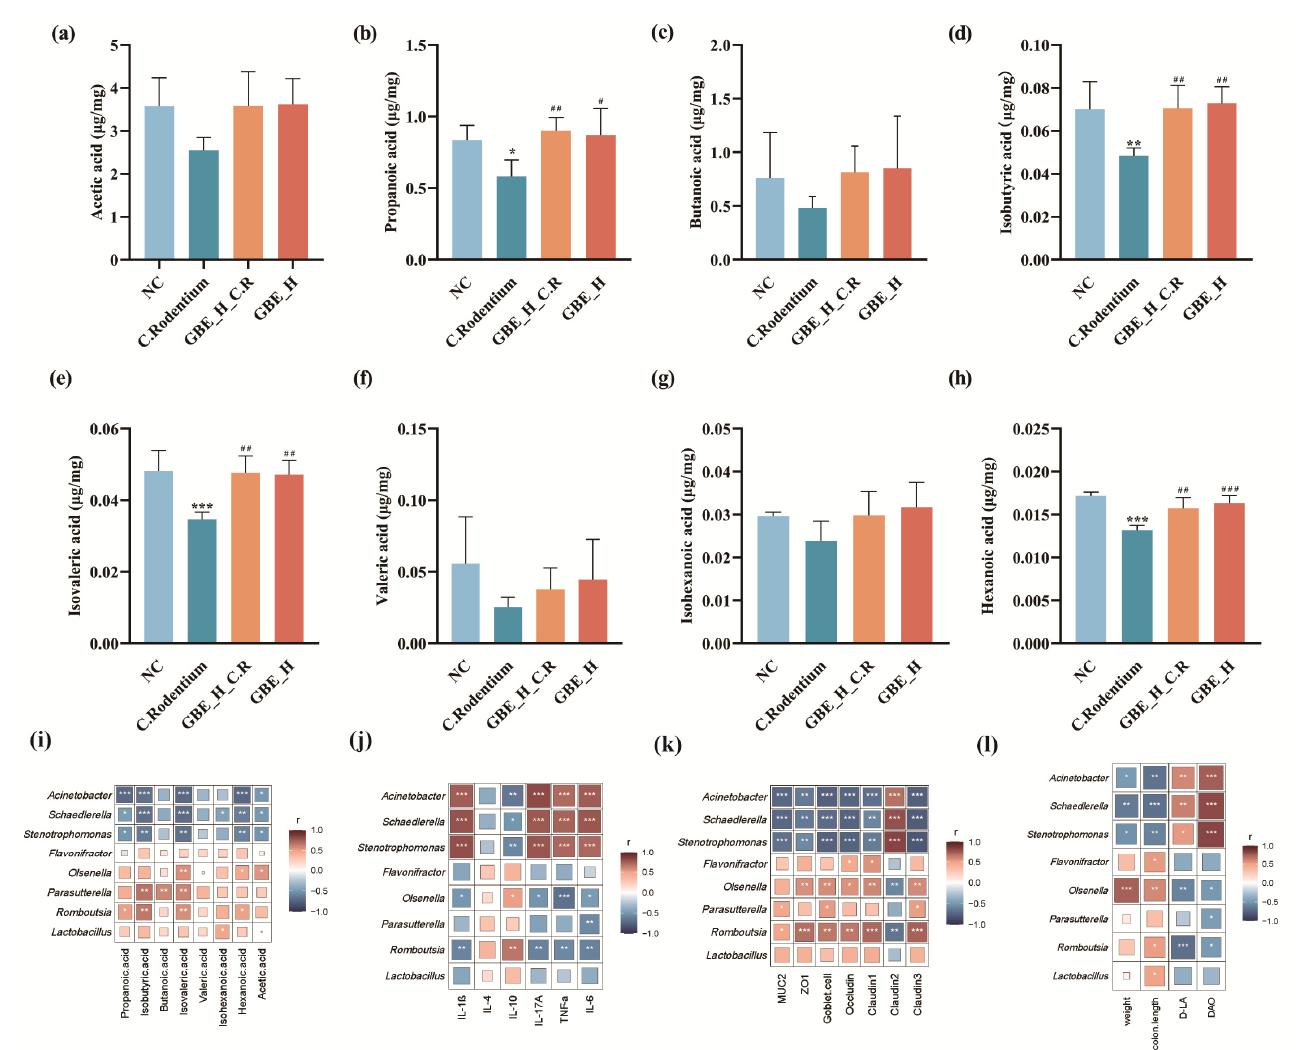
Figure 8. Mean SCFAs levels within the mouse colonic contents and Spearman’s correlation analysis. ( a ) Acetic acid. ( b ) Propanoic acid. ( c ) Isobutyric acid. ( d ) Butanoic acid. ( e ) Isovaleric acid. ( f ) Valeric acid. ( g ) Isohexanoic acid. ( h ) Hexanoic acid. Spearman’s correlation analysis of changes between abundances of individual genera and ( i ) SCFAs; ( j ) cytokines; ( k ) TJ, MUC2, ZO1, and goblet cell levels; and ( l ) weight, colon length, and D-LA and DAO levels. *** p < 0.001, ** p < 0.01, and * p < 0.05 vs. NC group; ### p < 0.001, ## p < 0.01, and # p < 0.05 vs. C. Rodentium